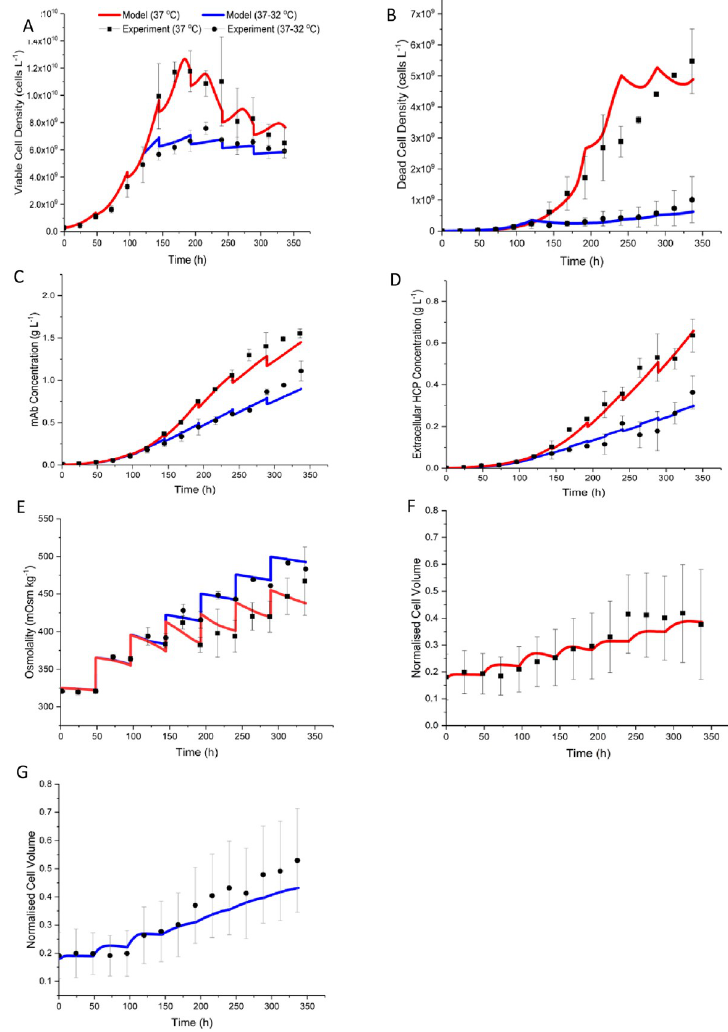
Fig 1. Comparison of model simulation results with experimental data. The red and blue lines represent the model output for the physiological and mild hypothermic bioreactors, respectively. The experimental data are represented in square (physiological temperature) and circular (mild hypothermia) points for (A) viable cell density; (B) dead cell density (C) mAb titre, (D) extracellular HCP concentration, (E) culture osmolality, (F) and (G) normalised cell volume for physiological temperature and mild hypothermic case, respectively. Error bars represent one standard